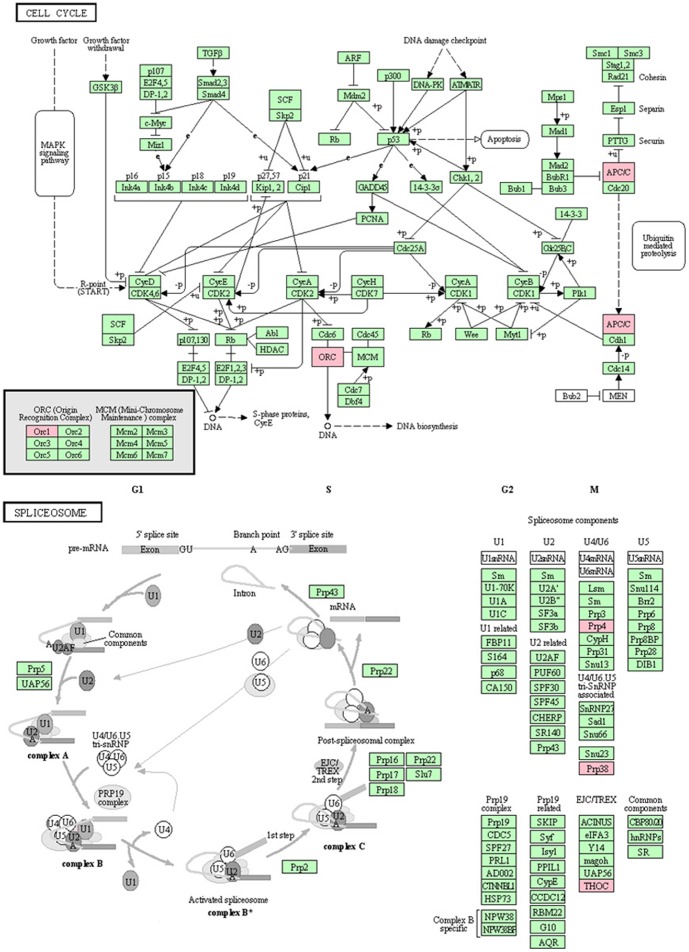
The distribution of three DPGs in two KEGG pathways: cell cycle and splicesome.Three DPGs are 4998 (ORC1)-84950 (PRPF38A), 246184 (CDC26)-9128(PRPF4), and 10189 (ALYREF)-51529 (APC11). These six genes act as bridges in the regulation between DNA replication, proteolysis, RNA splicing, and cell cycle; the figure is drawn based on KEGG pathway mapping tool.